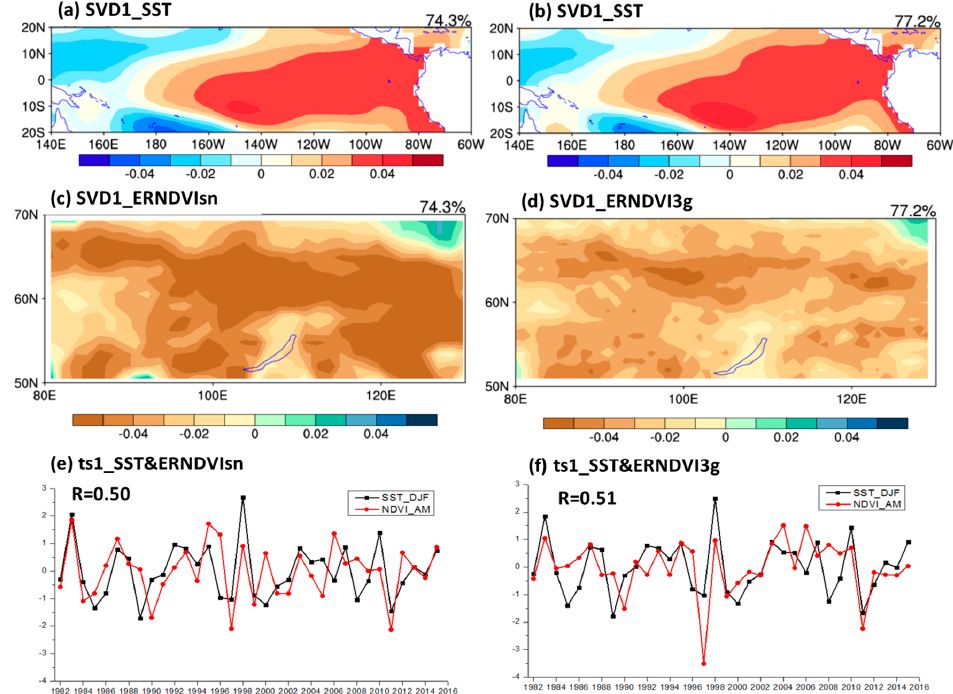
Figure 5. Spatial patterns and time-series of expansion coefficients for the first leading paired mode of winter SST (tropical Pacific) and ERNDVI for the period 1982 to 2015 via the SVD analysis: ( a ) the paired mode of SST using NDVIsn; ( b ) the paired mode of SST using NDVI3g; ( c ) the paired mode of ERNDVI using NDVIsn; ( d ) the paired mode of ERNDVI using NDVI3g; ( e ) the time-series of SST (black squares) and ERNDVI (red dots) using NDVIsn; ( f ) the time-series of SST (black squares) and ERNDVI (red dots) using NDVI3g. The time-series amplitudes are normalized based on standard deviation. The variance explained by each SVD is shown on the right corner in ( a – d ). Table 3. Correlation coefficients between the first leading SVD time-series (SST and NDVI) and various winter climate indices based on the two NDVI datasets.